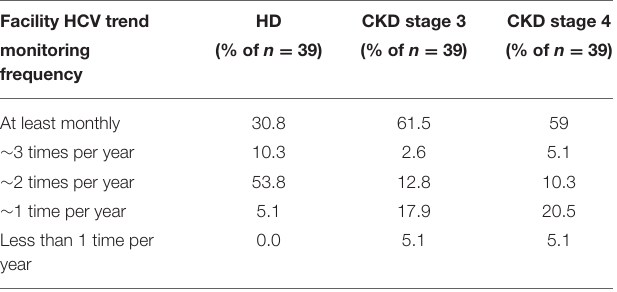
TABLE 13C | Situations after which HCV testing is typically performed (China Medical Director HCV survey, 2021).